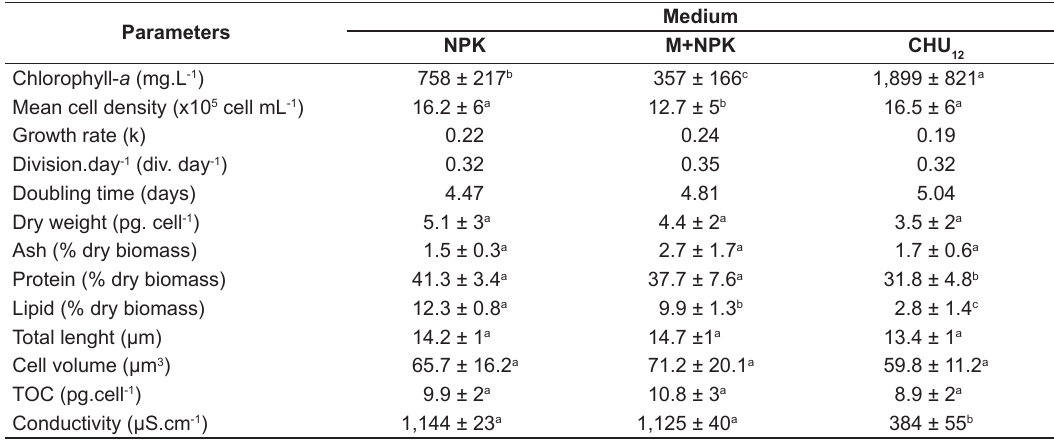
Table 2. Parameters of Ankistrodesmus gracilis cultured in inorganic fertilizer (NPK), macrophyte with inorganic fertilizer (M+NPK) and commercial media (CHU ). Data represent mean ± SD* of three replicates per medium 12 (NPK, M+NPK and CHU ). 12